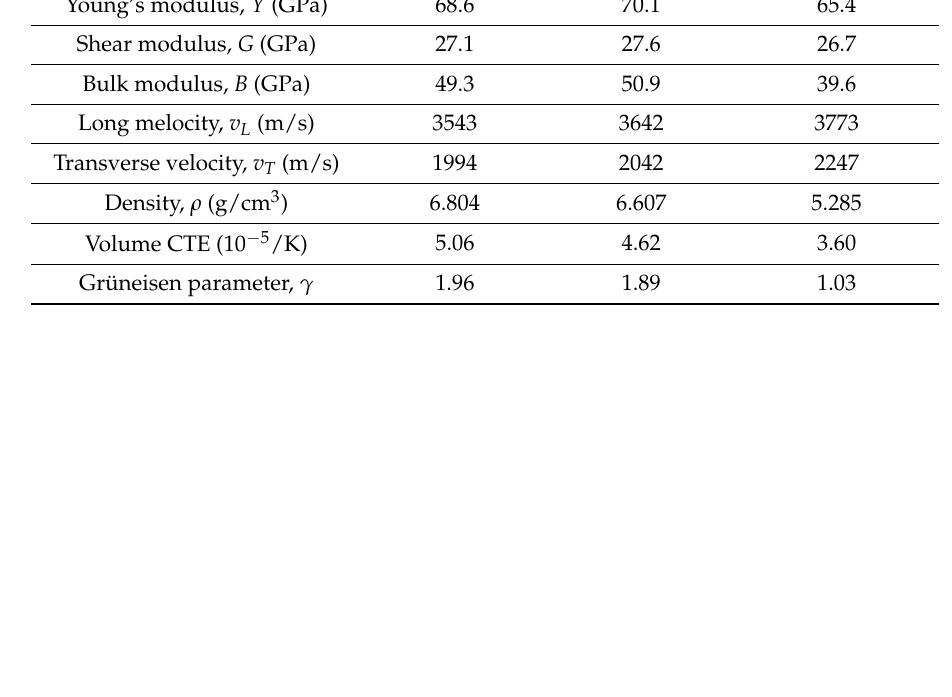
Figure 3. Temperature-dependent ( a ) thermal conductivity and ( b ) thermoelectric figure of merit. Table 1. Elastic moduli, speed of sound, density, volumetric coefficient of thermal expansion, and Grüneisen parameters for Sc 2 Te 3 compared with PrTe 1.46 and LaTe 1.46 [7].